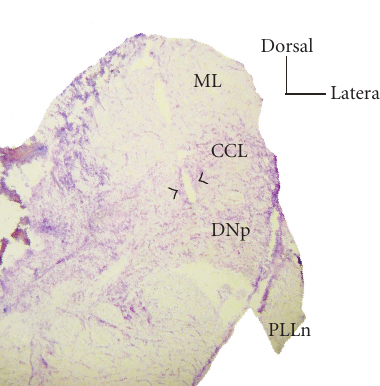
Figure 1: Reconstruction of a recording site in the medulla. The figure shows a cresyl-violet stained section through the dorsal half of the right brainstem of a goldfish. The course of an electrode penetration can be tracked from the brain surface through the molecular layer into the crest cell layer. At the endpoint of the penetration a current was applied to lesion the tissue at a physiologically characterized recording site (arrowheads). Note that the electrode was angled by about 20 ◦ for easier access to the brain surface, resulting in an angular orientation of the electrode track with respect to the dorsal surface of the brain. Abbreviations: ML molecular layer, CCL crest cell layer, DNp deep neuropil, PLLn posterior lateral line